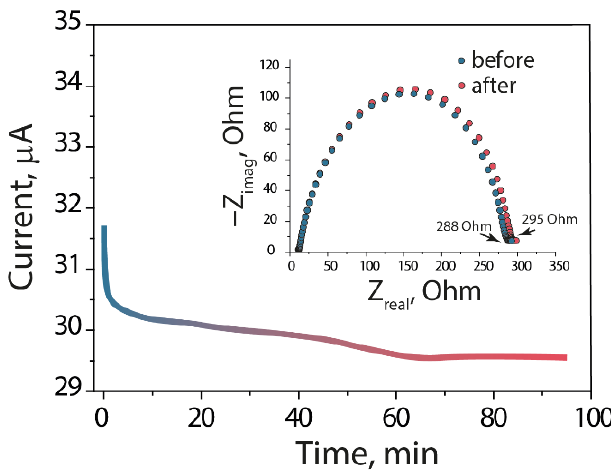
Figure 4. Typical impedance spectra of the Al|SSEBS-Ph-EC-DMA|Al cell at ( a ) low and ( b ) high temperatures .